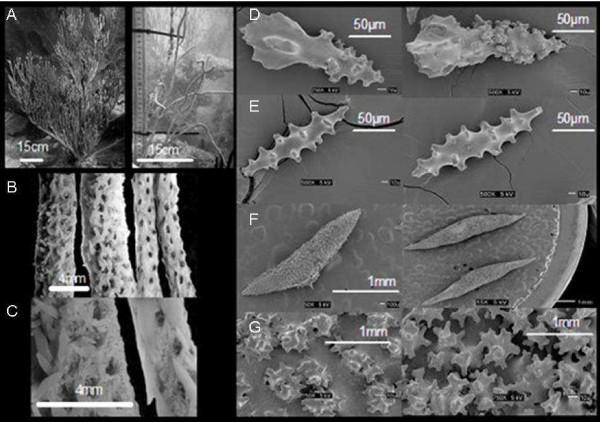
Differences among colonies inhabiting deep and shallow areas. A. Colonies in shallow areas (left), compared to deep colonies (right) are more branched and bigger in size. Thicker colonies are found in shallow areas with smaller spindles and more polyps per area (B and C). Right showing differences among sclerites; club (D), capstan (E), spindle (F) and spindle close up (G) of colonies inhabiting shallow (left) and deep (right) areas. Spindles of shallow area colonies compared to deep colonies are bigger in size. The surface arrangements of warts are sparser in shallow area colonies (G).